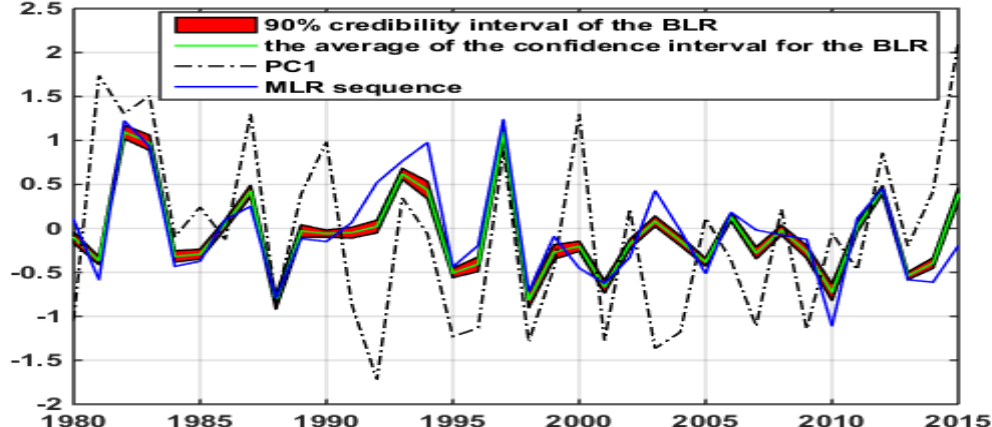
Figure 9. Comparison among the BLR-predicted results, the MLR sequence and PC1 (the red area represents a 90% confidence interval of the BLR model, and the thick green solid line is the average of the confidence interval for BLR).